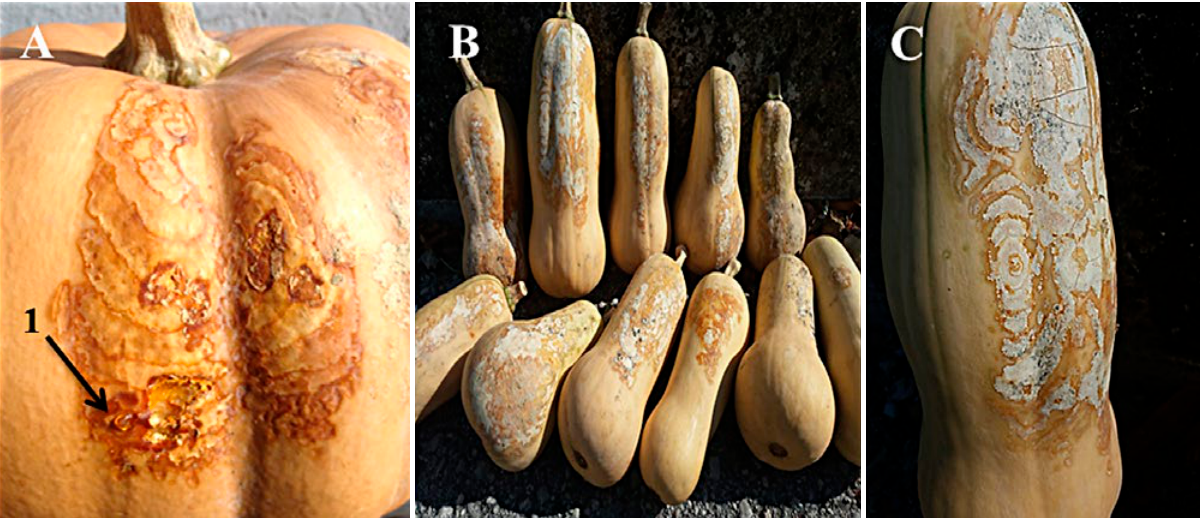
Figure 1. Typical symptoms of black rot caused by Stagonosporopsis cucurbitacearum on butternut squash fruit. A, Infected fruit showing exudate (arrow 1). B and C, Irregularly circular and white spots covered by pycnidia.